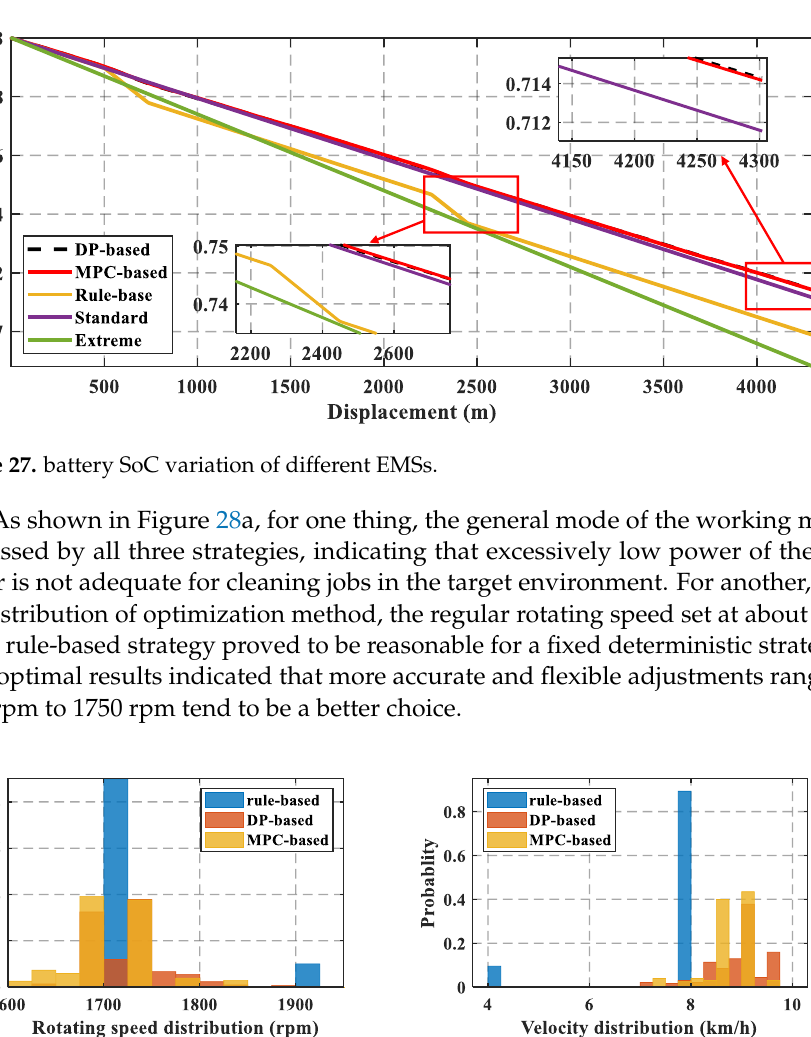
Table 6. Energy consumption performance comparison of different strategies.